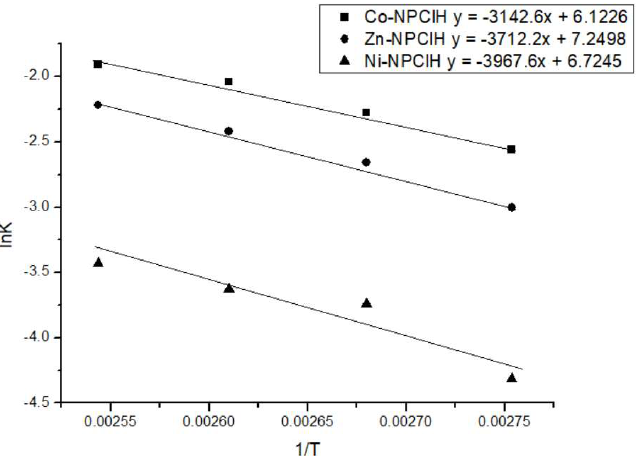
Figure 5. Arrhenius plots for the formation of cyclic carbonate from the cycloaddition of CO 2 and GIE using catalysts M − NPClH.